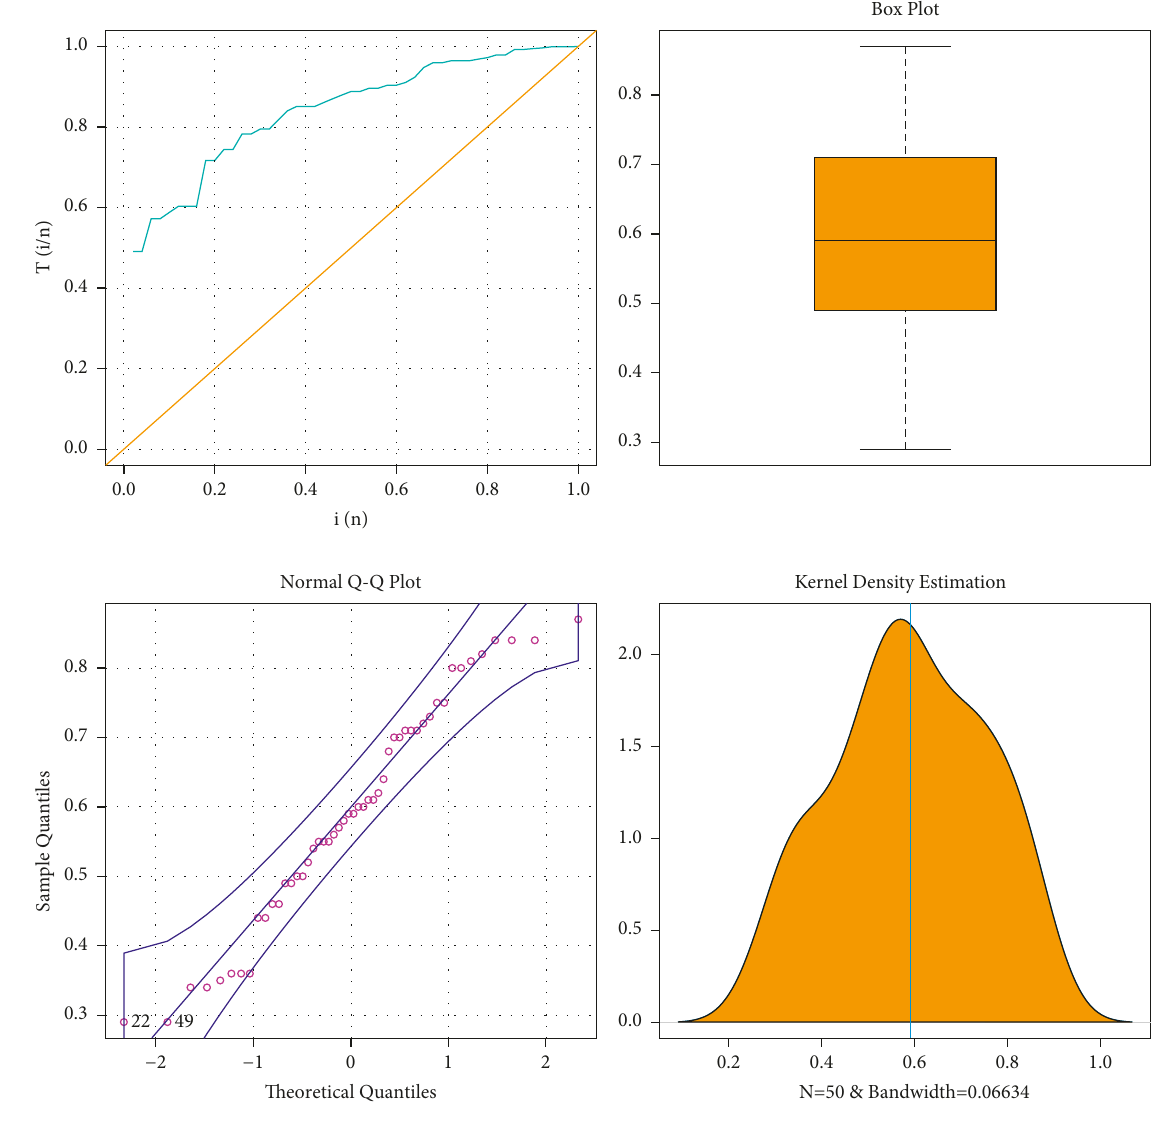
Figure 7: TTT plot, box plot, Q-Q plot, and KDE for relief time data